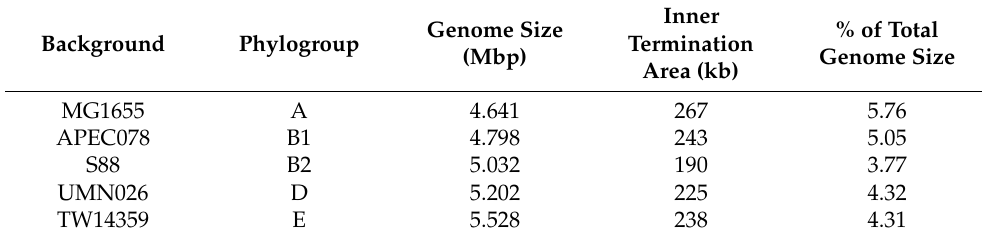
Table 2. Genome parameters of the different E. coli phylogroups.